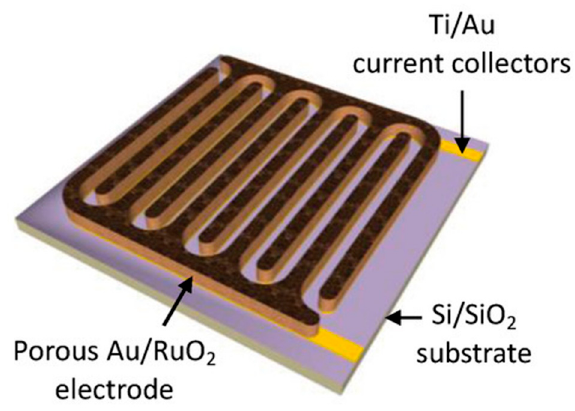
Figure 16. A schematic illustration of a microsupercapacitor with 3D porous Au/RuO 2 electrodes. Reprinted with permission from ref. [111] Copyright (2019) Wiley.